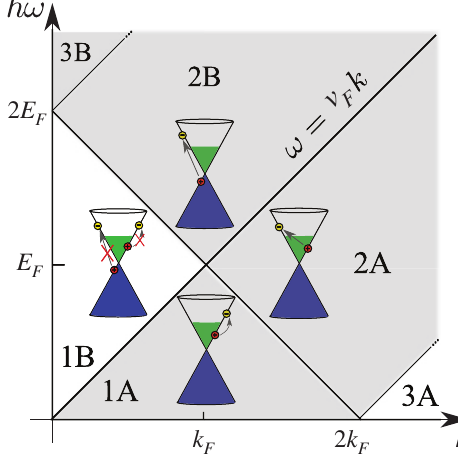
Figure 2: Electronic contributions to the graphene conductivity in different regions of phase space [20]. Region 1B ( k < ω / v , k < 2 k − ω / v ) of phase space is protected F F F from Landau damping arising from both interband and intraband transitions. The lossy (shaded) regions are 1A ( ω / v < k < 2 k + ω / v and 2A ( ω / v , k > 2 k − ω ), dominated by F F F F Landau damping resulting from intraband transitions, and 2B < k < ω / v < 2 k + k ) and 3B ( k < ω / v (2 k − ω / v , ω / v F F F F F by indirect and direct interband transitions, respectively.